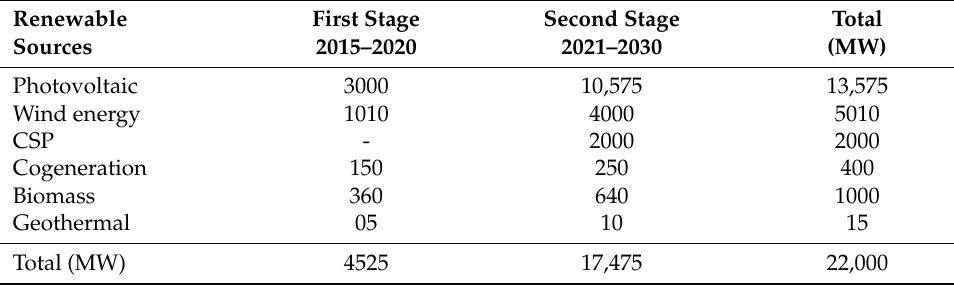
Table 10. Renewable energy targets in Algeria